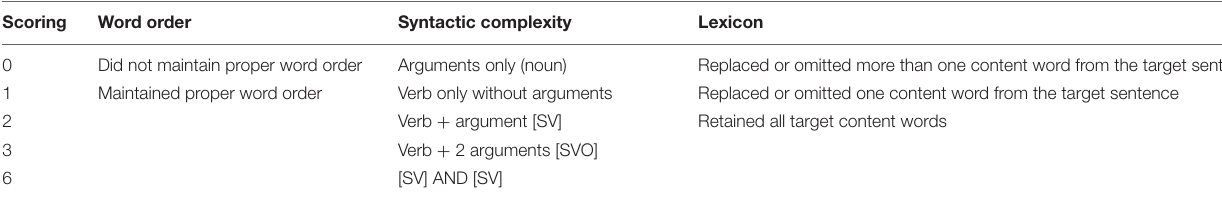
TABLE 2 | Metric score for word order, syntactic complexity, and